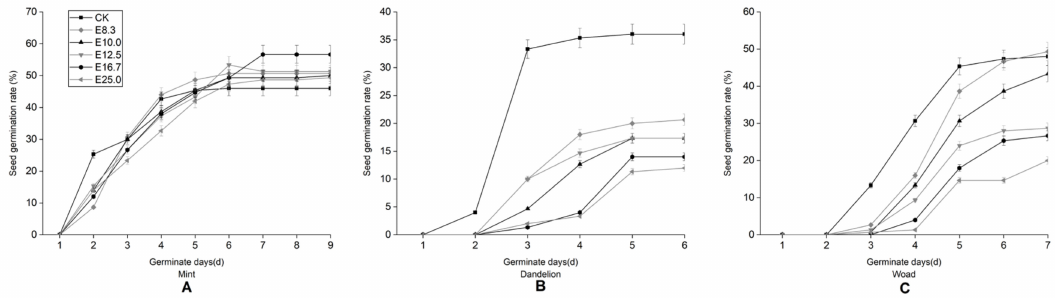
Figure 1. Effect of leaf aqueous extract of fig tree on seed germination rate of ( A ) Mint, ( B ) Dandelion and ( C ) Woad. Values are reported as mean ± SD, n = 3. CK, 0.0 g/L; E8.3, 8.3 g/L; E10.0, 10.0 g/L; E12.5, 12.5 g/L; E16.7, 16.7 g/L; E25.0, 25.0 g/L.